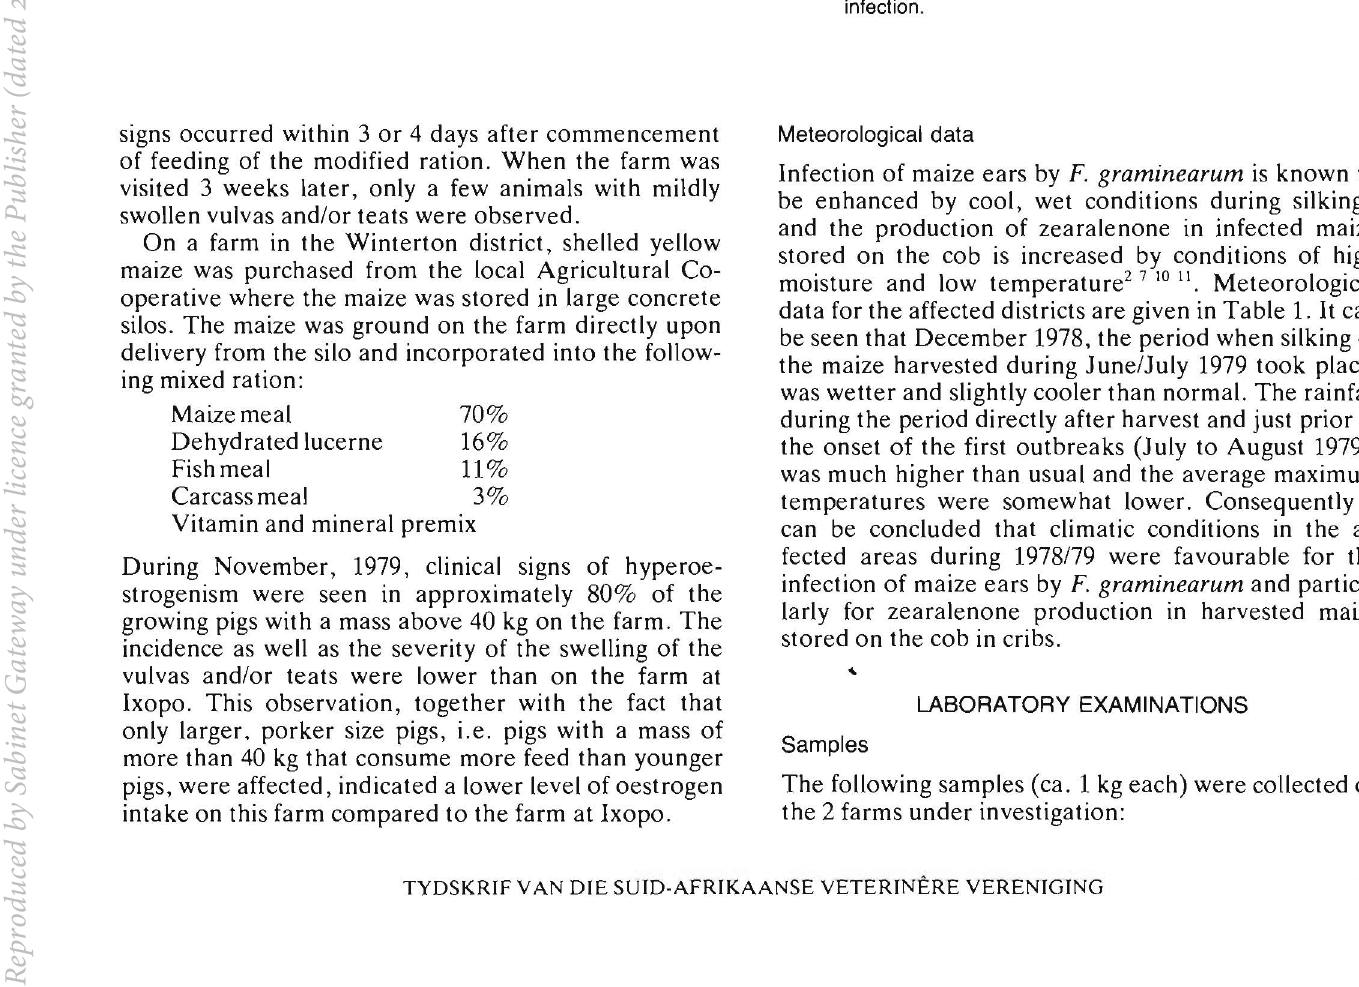
Fig. 1. Swelling and reddening of the vulva in a prepubertal gilt. Fig. 2. Maize ears stored in a crib and showing the characteristic